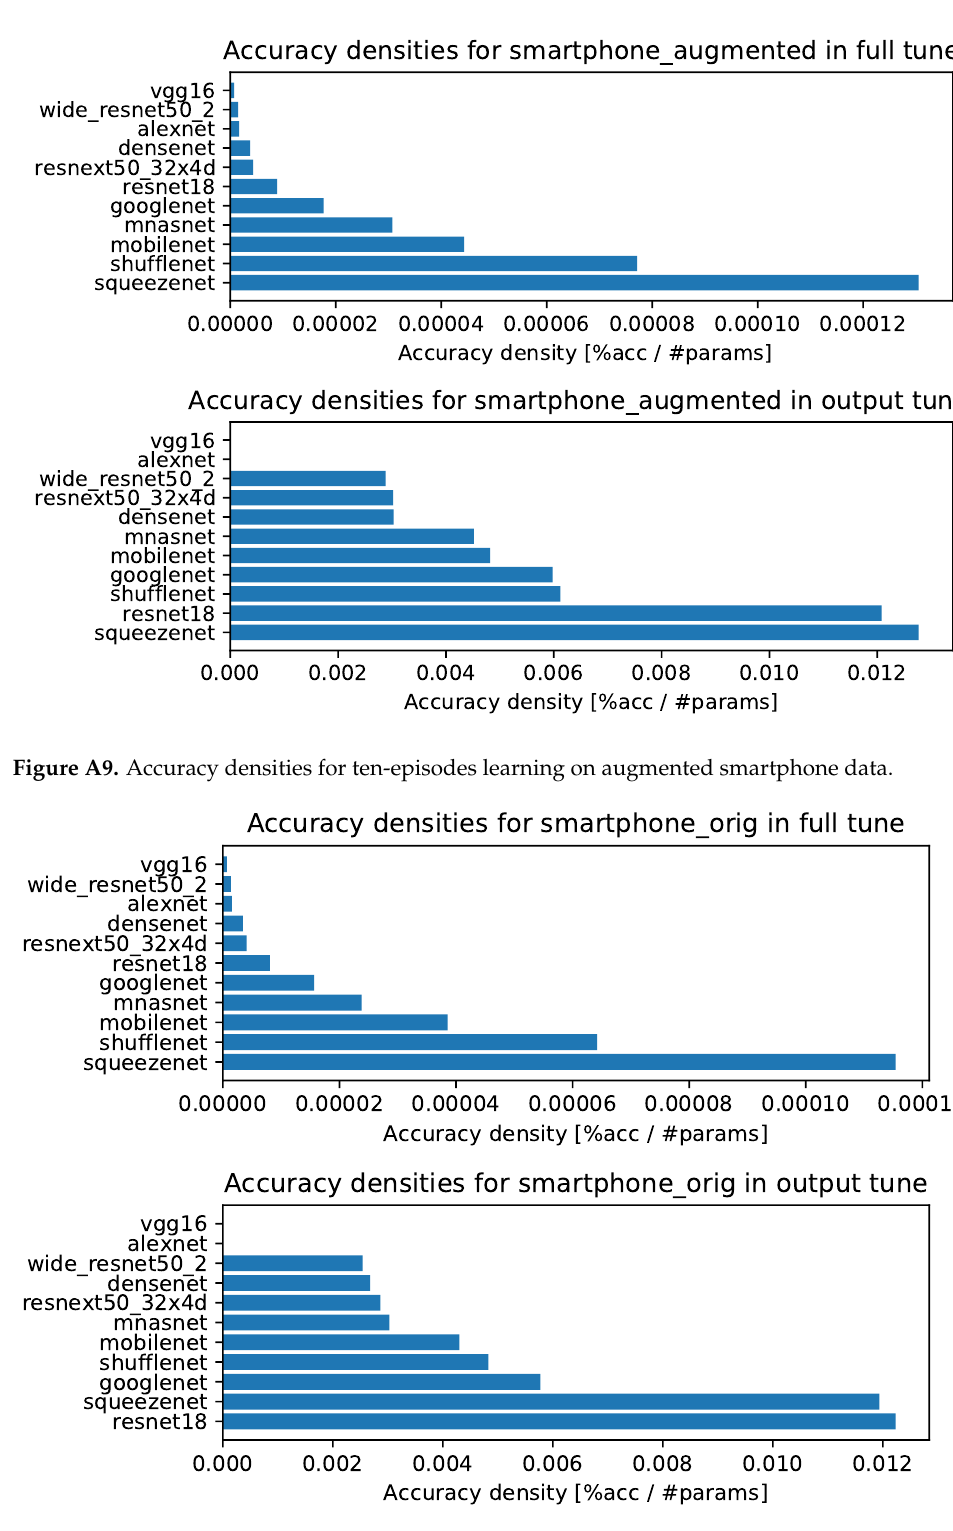
Figure A10. Accuracy densities for ten-episodes learning on original smartphone